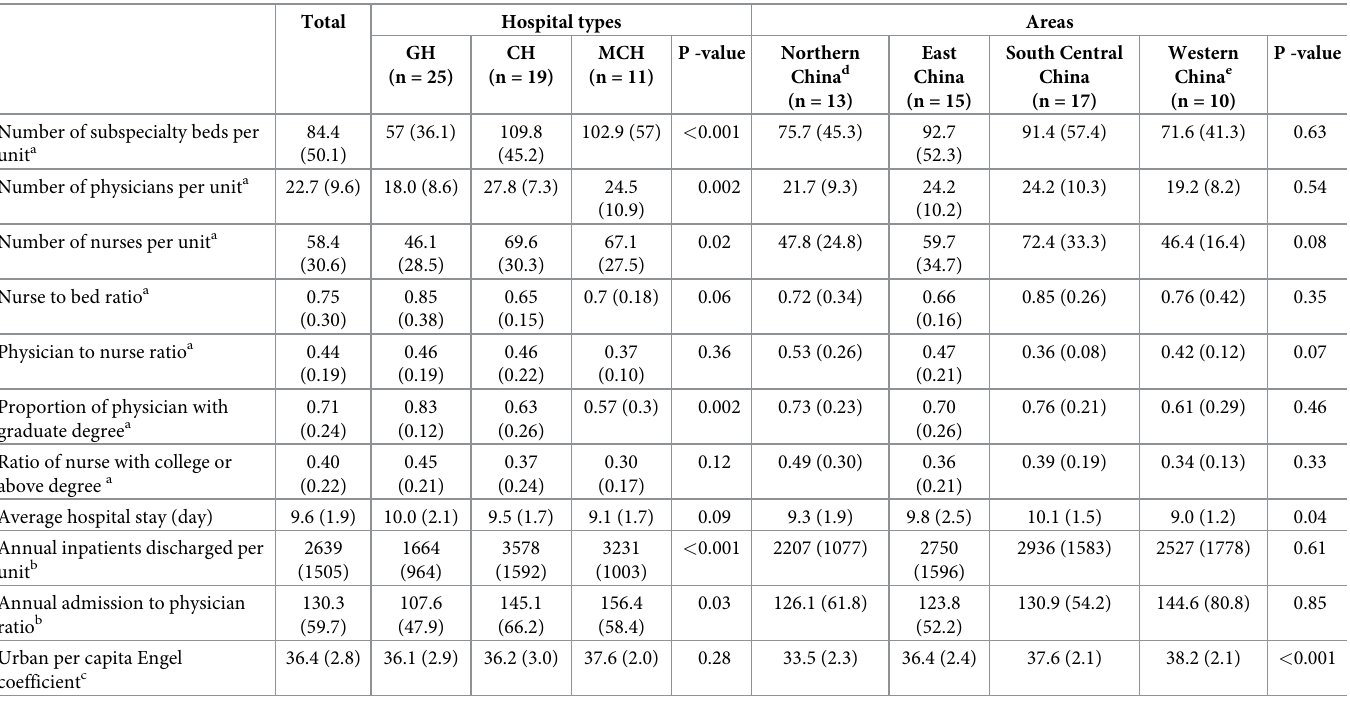
Table 1. Characteristics of the participating